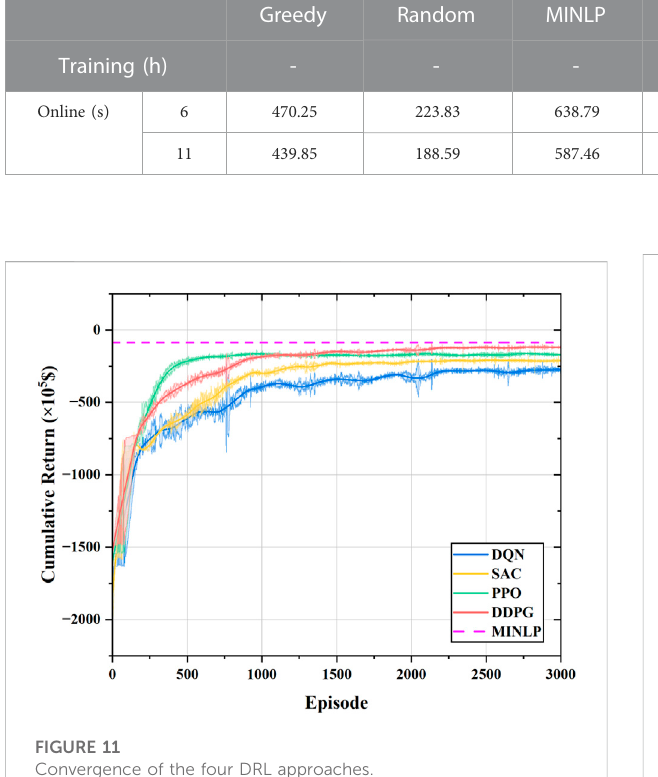
FIGURE 11 Convergence of the four DRL approaches.